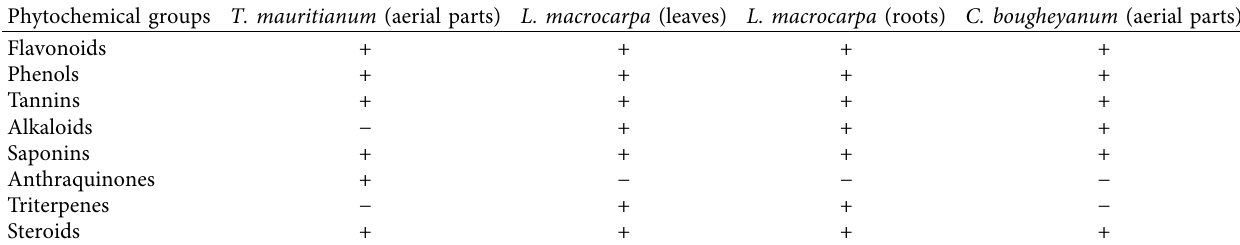
Table 1: Major phytochemical groups of the studied plant extracts.